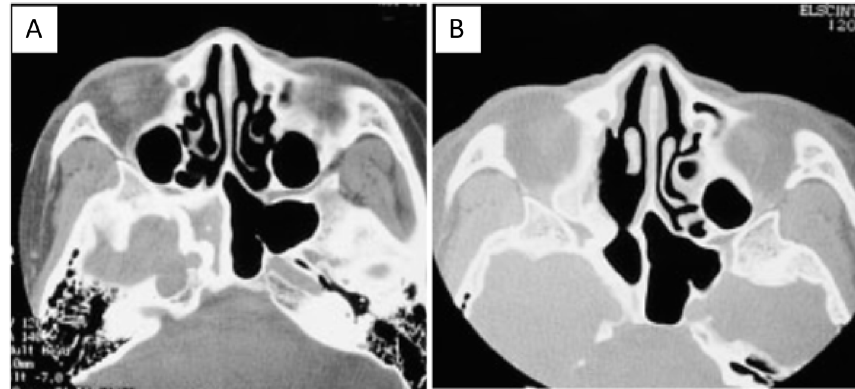
Fig. 2 Case 2. Right sphenoid sinus fungal ball. CT scan coronal view ( A left) revealing a complete hypodense filling of the right sphenoid sinus associated with a regular thickening along the bony walls of the sinus with central hyperdensity. Postoperative CT scan ( B right) of a transethmoidal approach to the right sphenoid